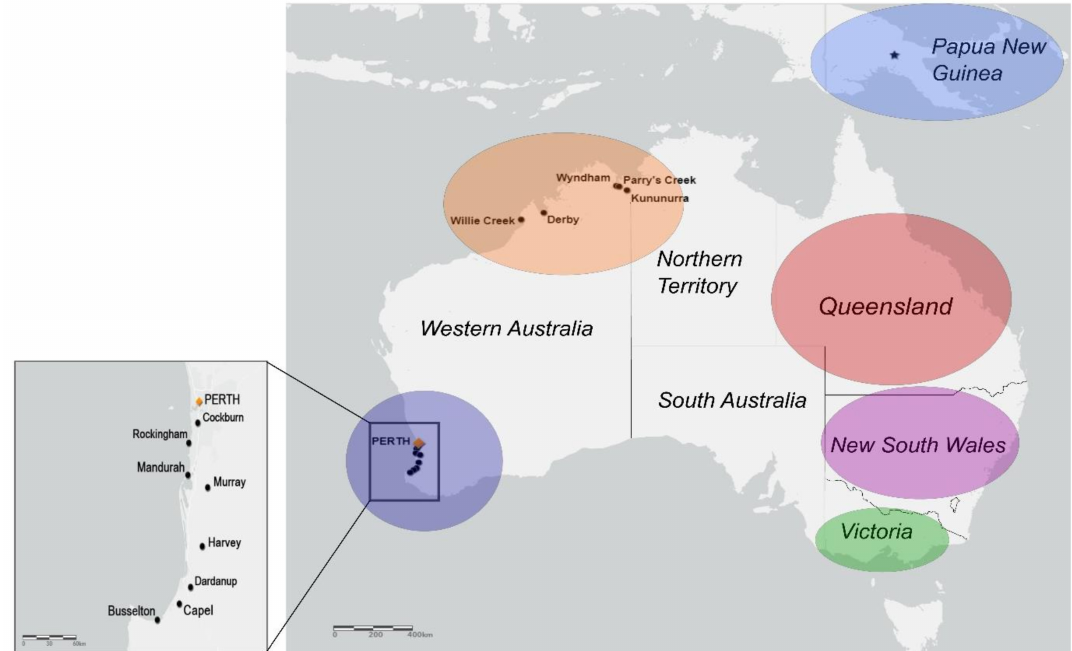
Figure 1. Sampling locations of Barmah Forest virus (BFV) isolates selected for sequencing. Individual locations within Western Australia were known and so are named. Locations were classified into larger, colour-coded geographical regions. Stars indicate locations of clinical isolate sampling, and dots indicate locations of mosquito-derived isolate sampling. Perth, the capital of Western Australia (WA) is indicated by an orange marker. The map was generated using ArcGIS